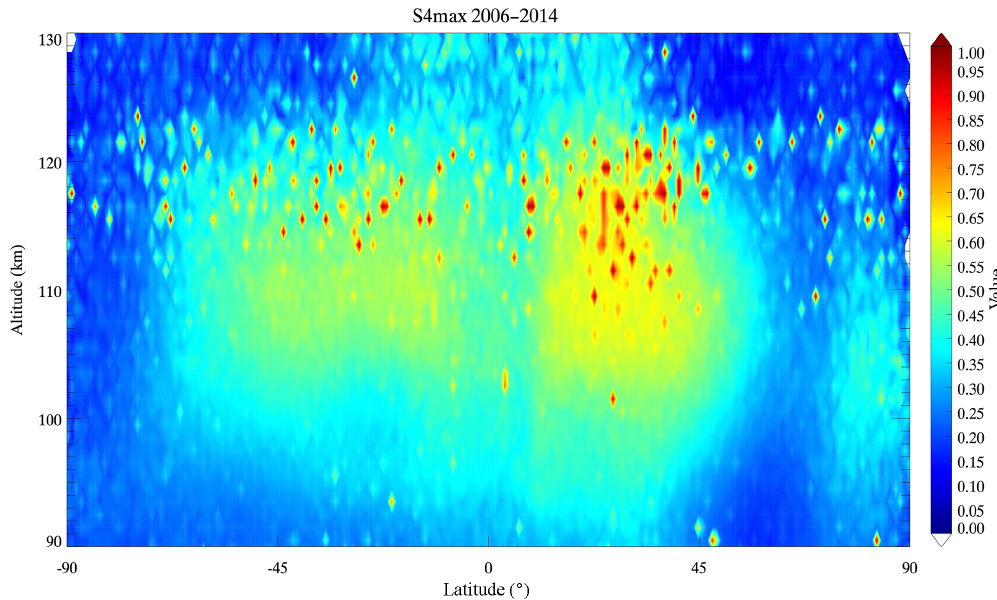
Figure 6. Altitude–latitude distribution of the E s intensity from 2006 to 2014, with a resolution of 1km altitude × 1 ◦ latitude.